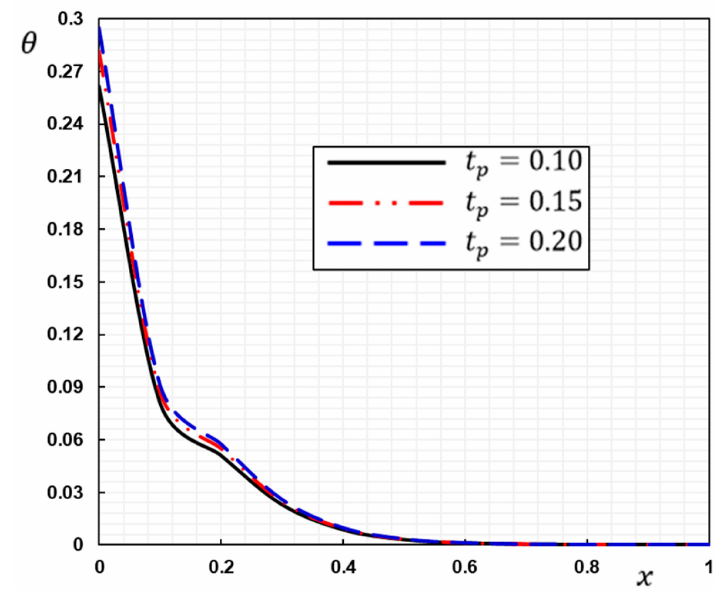
Figure 4. Variation of temperature θ against laser pulse duration t p